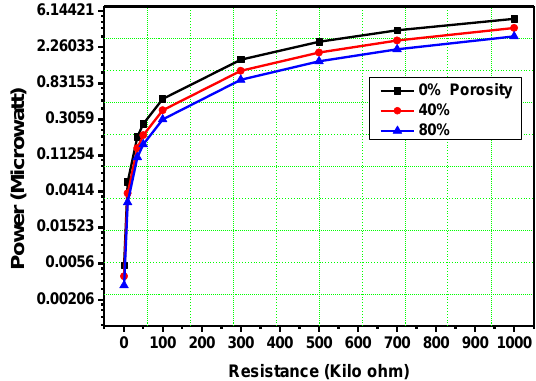
Figure 11. Effect of various porosities and resistances on power.